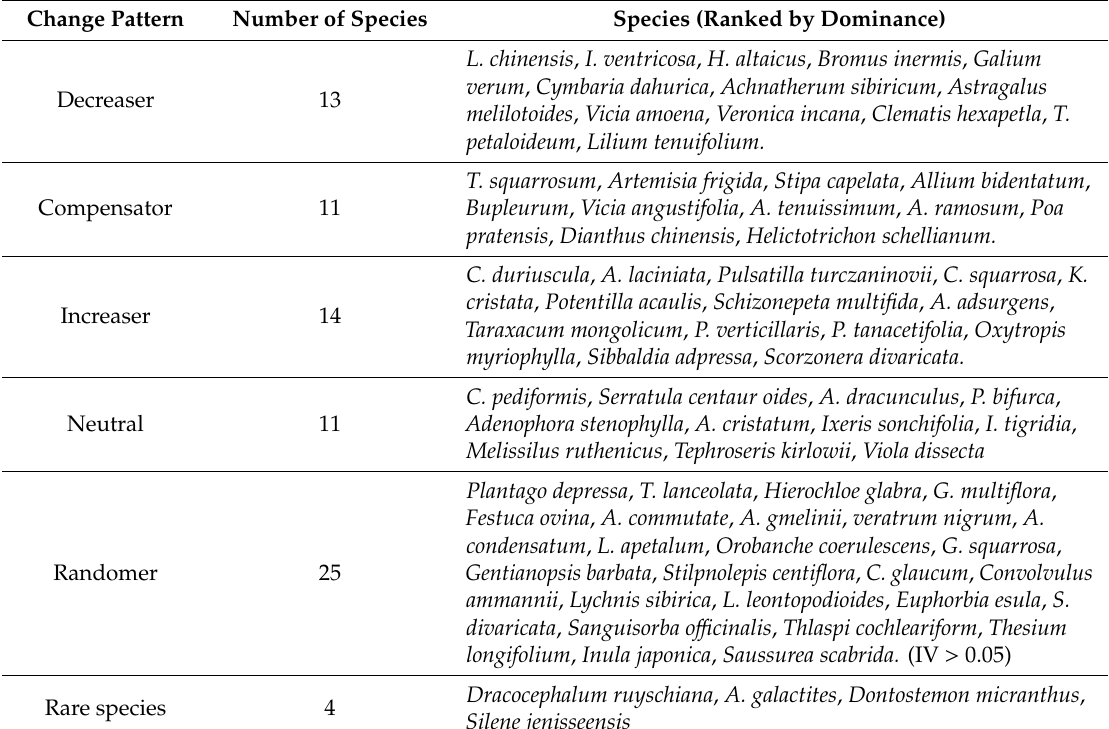
Table 1. Hulunbuir grassland community species ranks by